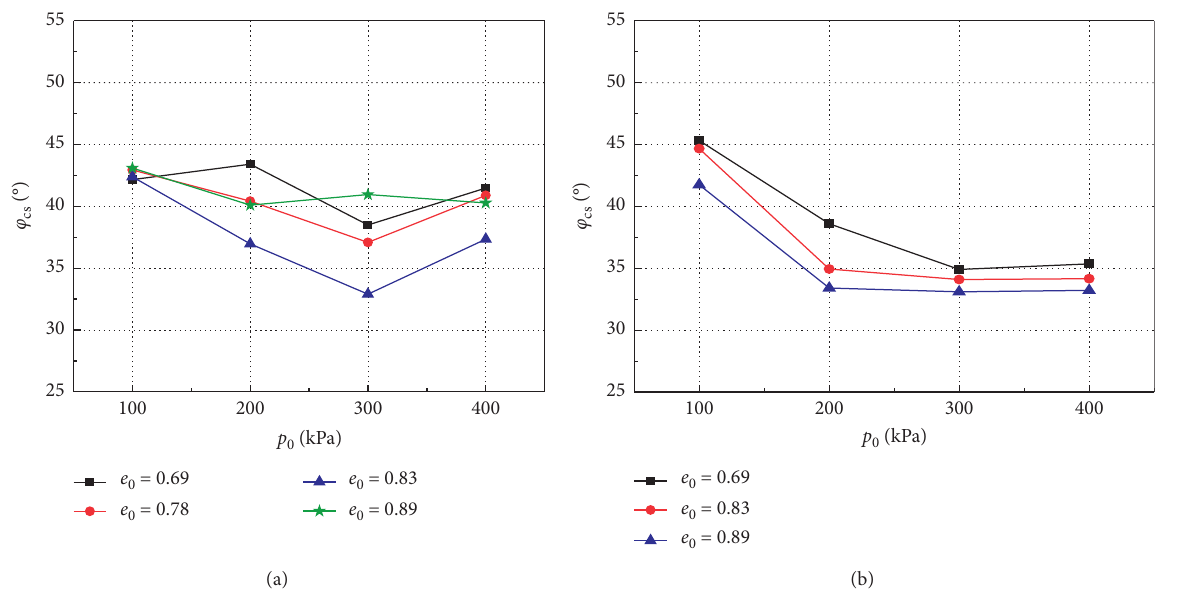
Figure 14: Relationship between φ cs and p 0 : (a) coral mud and (b) Taizhou